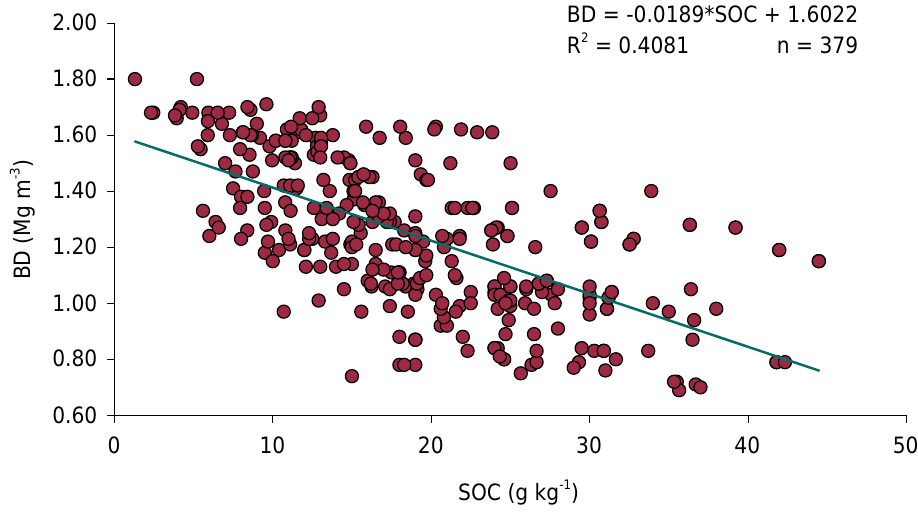
Figure 2. Correlation between soil organic C (SOC) (g kg -1 ) and bulk density (Bd) (Mg m -3 ) in soils from Brazilian Cerrado. r: Pearson’s correlation coefficient, statistically significant at 1 % level. n: number of